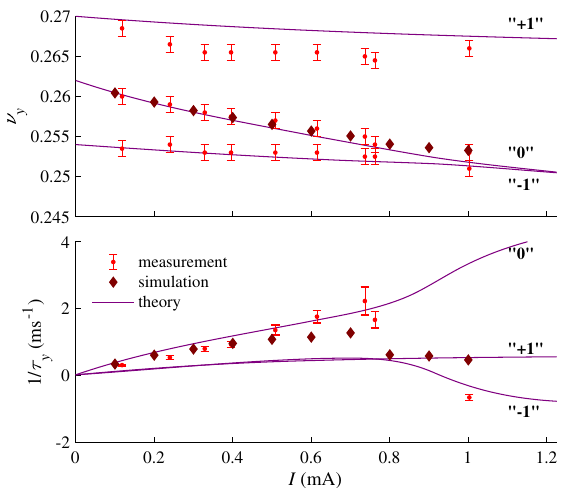
FIG. 6. Frequencies (top) and damping/growth rates (bottom) of vertical head-tail modes; ξ